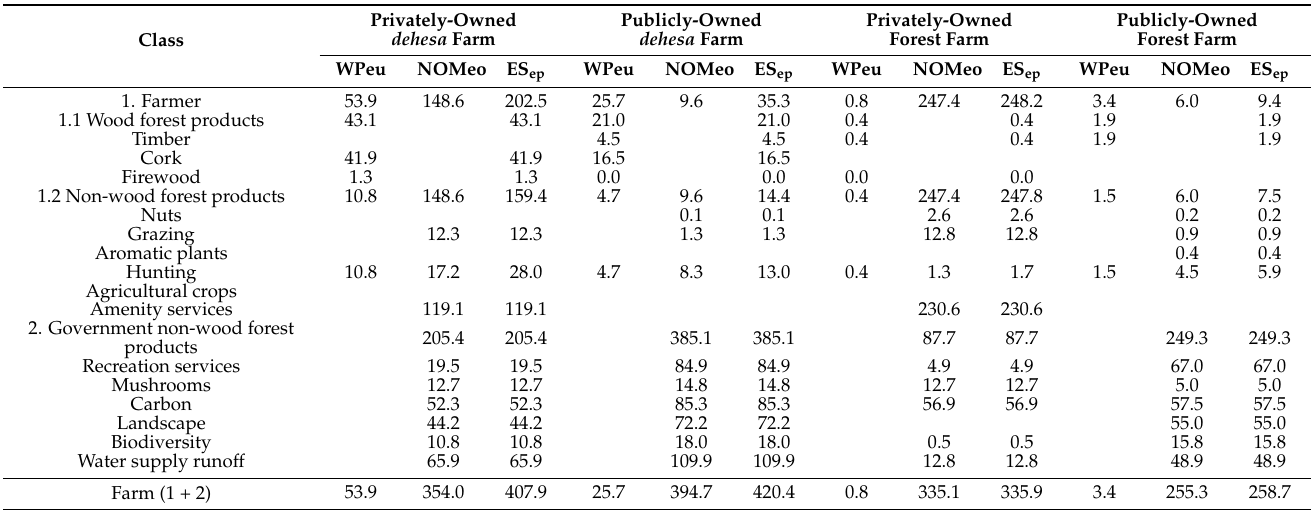
Table 5. Ecosystem services of the case-study large dehesa and forest farms in Andalusia under the AAS (2010: € /ha).